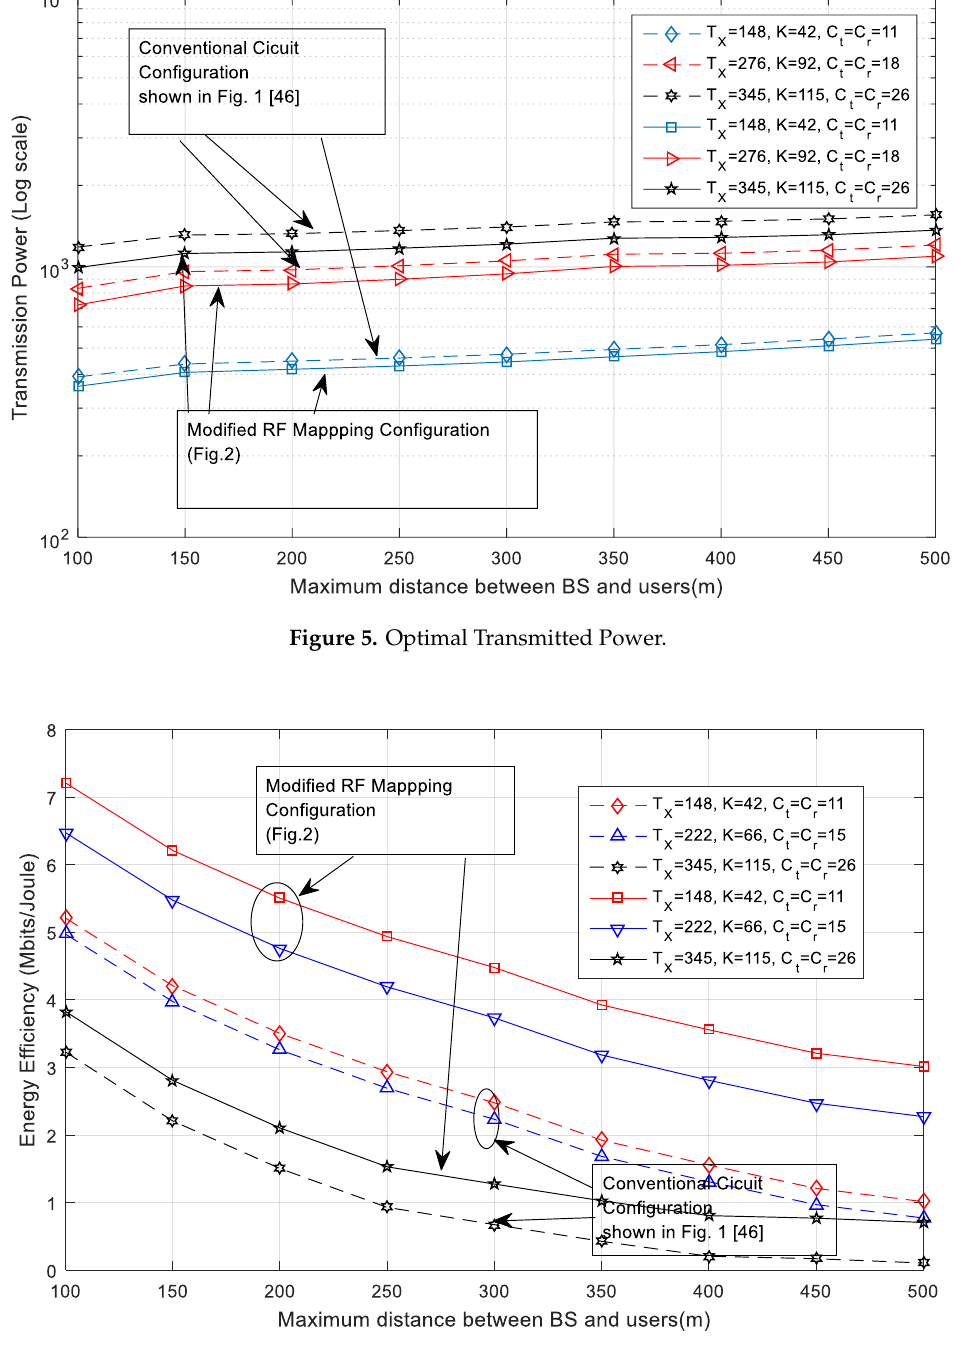
Figure 7. Comparison of the Energy Efficiency computed by using different algorithms.